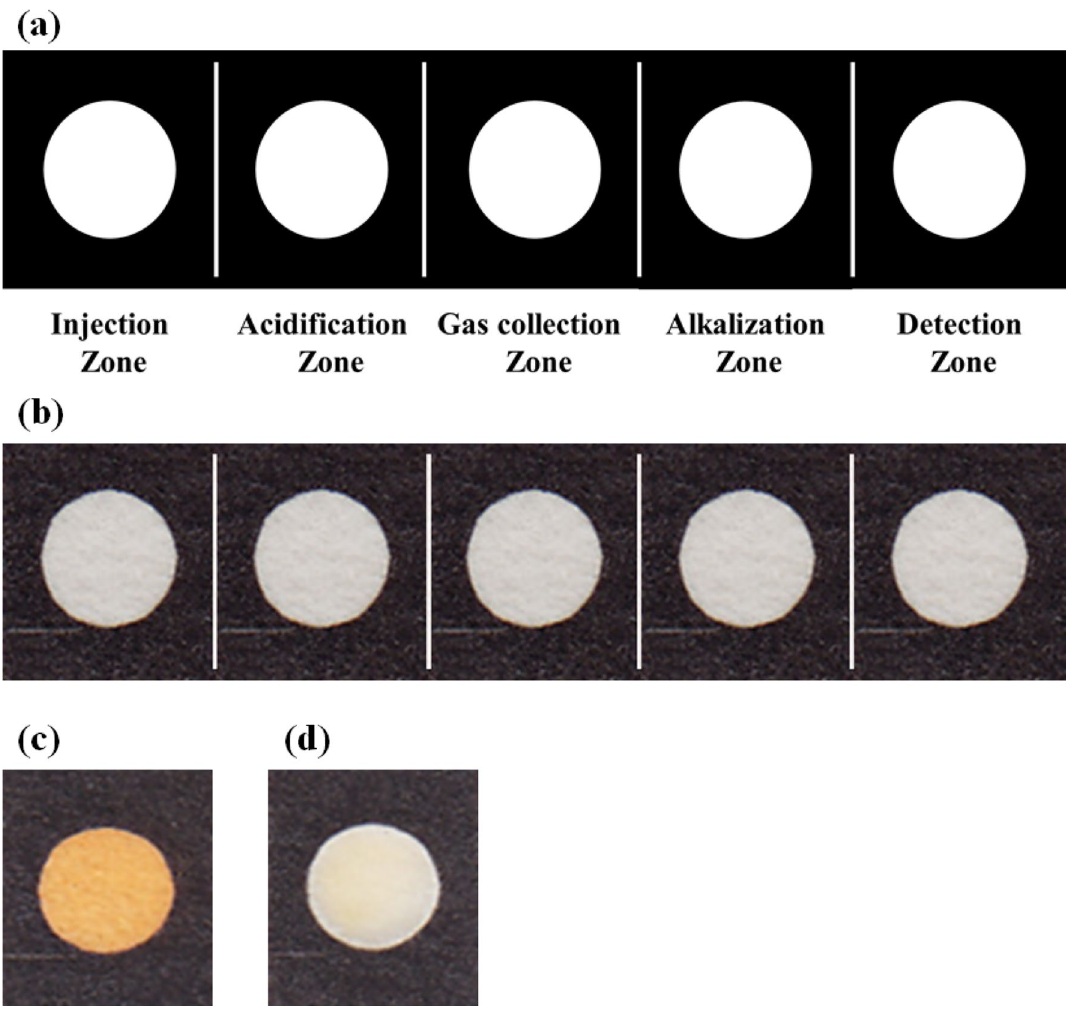
Figure 1. ( a ) The schematic pattern and ( b ) the image of fabricated µPAD, ( c ) the image of detection zone after injecting receptor, ( d ) the image of detection zone after exposing to 100.0 µmol L −1 of cyanide